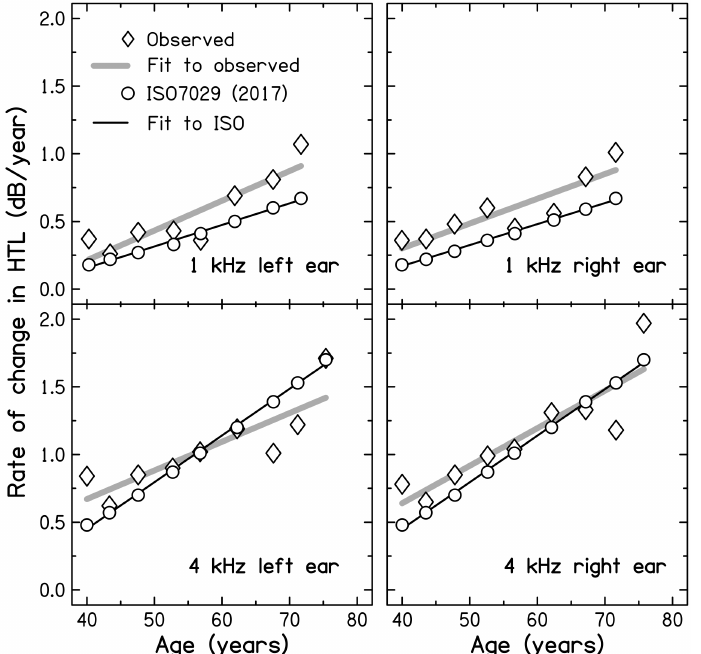
Figure 2. Rate of change of HTLs (dB/year) plotted against age group, as extracted from the data of Macrae [5] (triangles), based on linear fits to the data of Macrae (thick gray lines), based on ISO 7029 [4] (circles), and based on linear fits to ISO 7029 (thin black lines). Each panel shows results for one ear and one frequency, as indicated in the